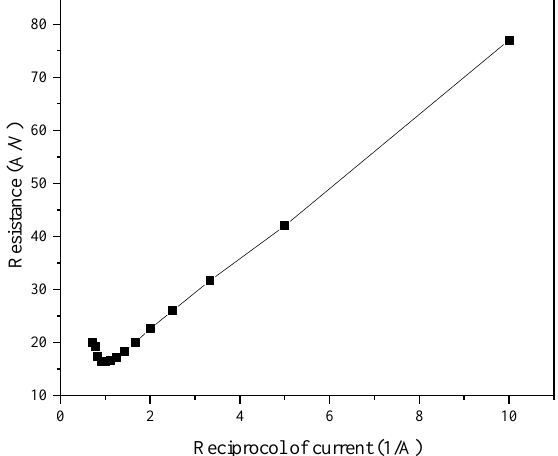
Figure 19. Two-stage ED limit current measurement curve.